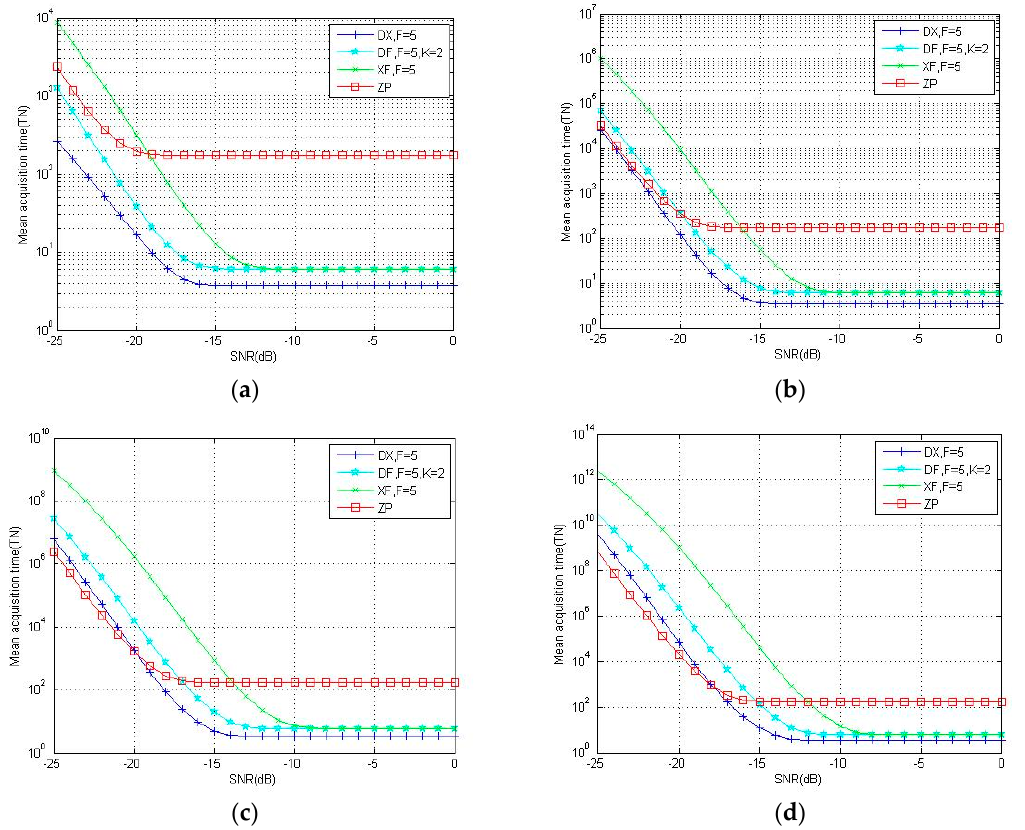
Figure 8. Theoretical results for mean acquisition time of Zero-padding (“ZP”), DC-XFAST (“DX”), DF-XFAST (“DF”) and XFAST (“XF”) with N equals to 4096, F equals to 5 and N th equals to 1( a ), 2( b ), 3( c ), 4( d ).